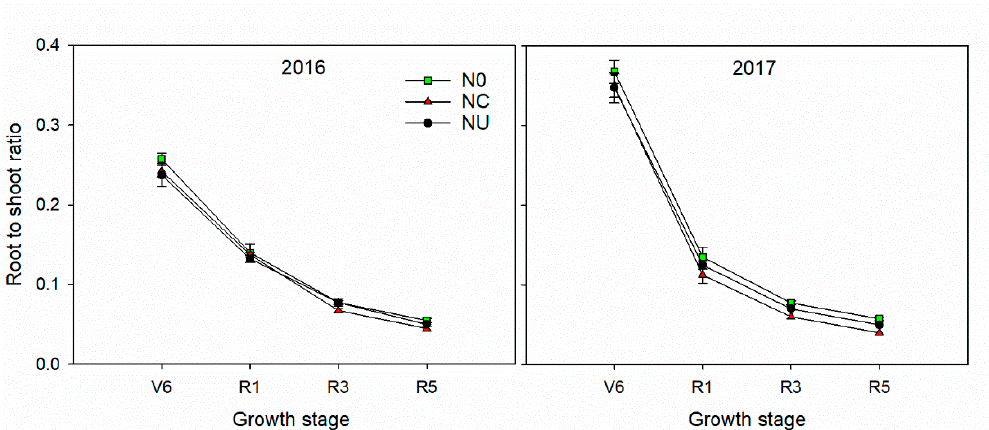
Figure 8. Root to shoot ratio over the entire growing season with the three treatments in 2016 and 2017 as follows: no N application (N0), combined controlled release urea and normal urea at a ratio of 1:2 (NC), and normal urea alone (NU).